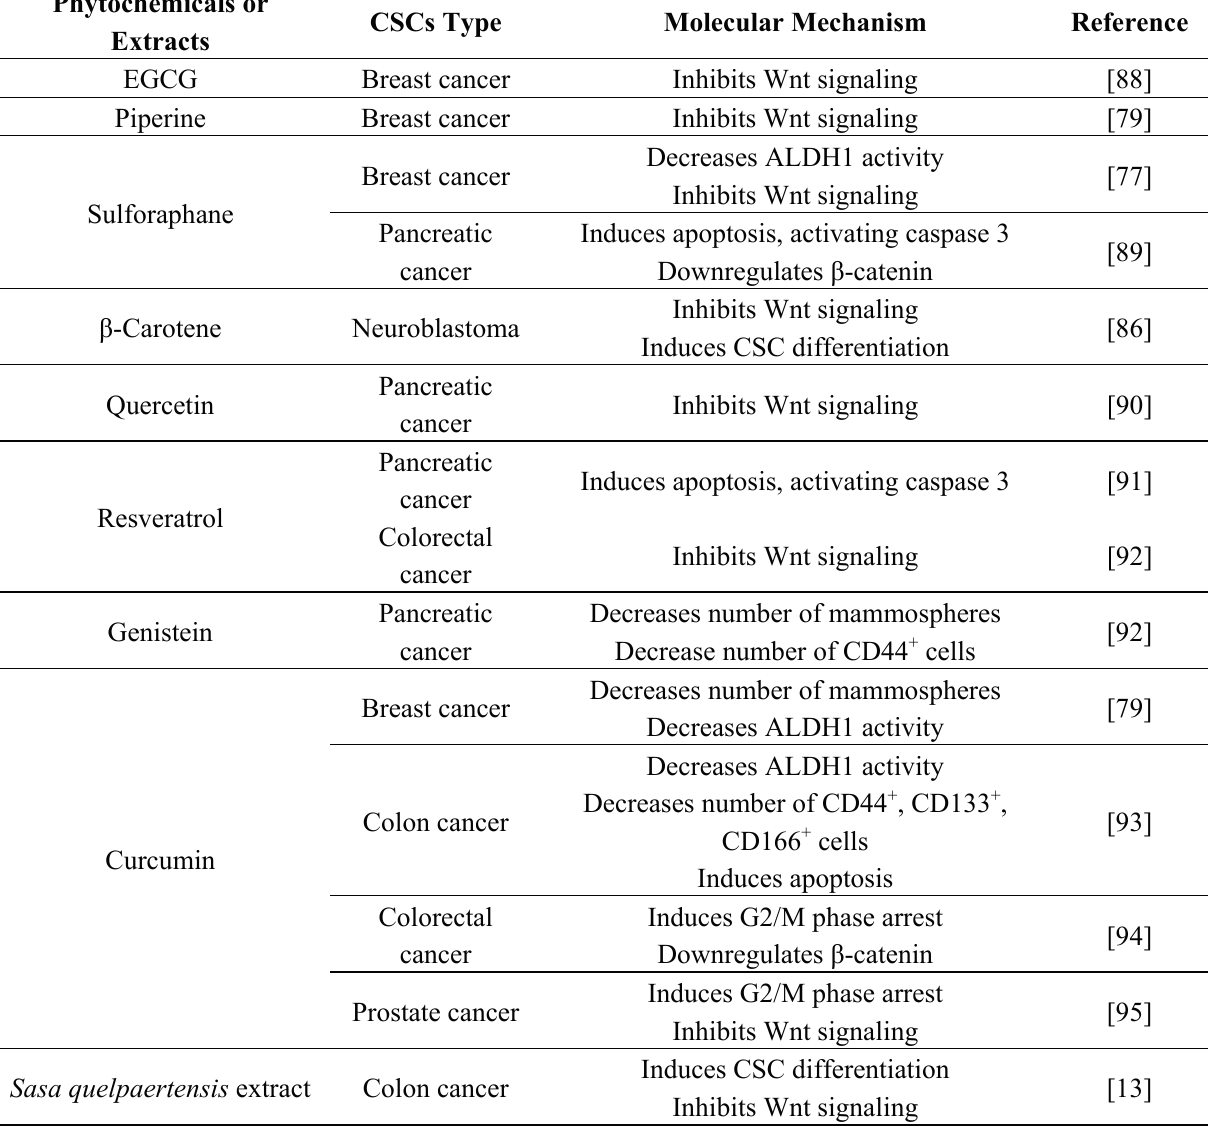
Table 2. Phytochemicals that are able to kill the cancer stem cells of tumors through specific molecular